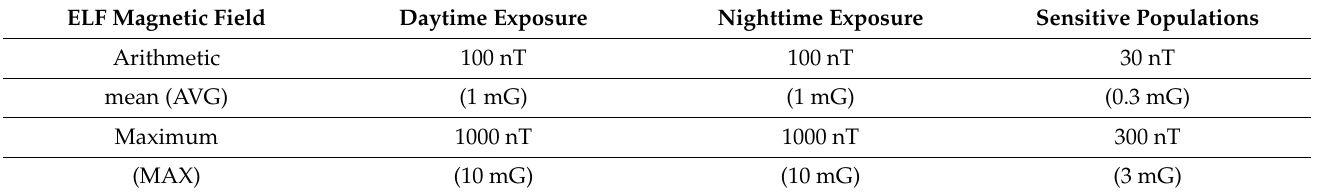
Table 3. Precautionary guidance values for the ELF (Extremely Low Frequency) magnetic fields. Reprinted from ref. [74]. ELF Magnetic